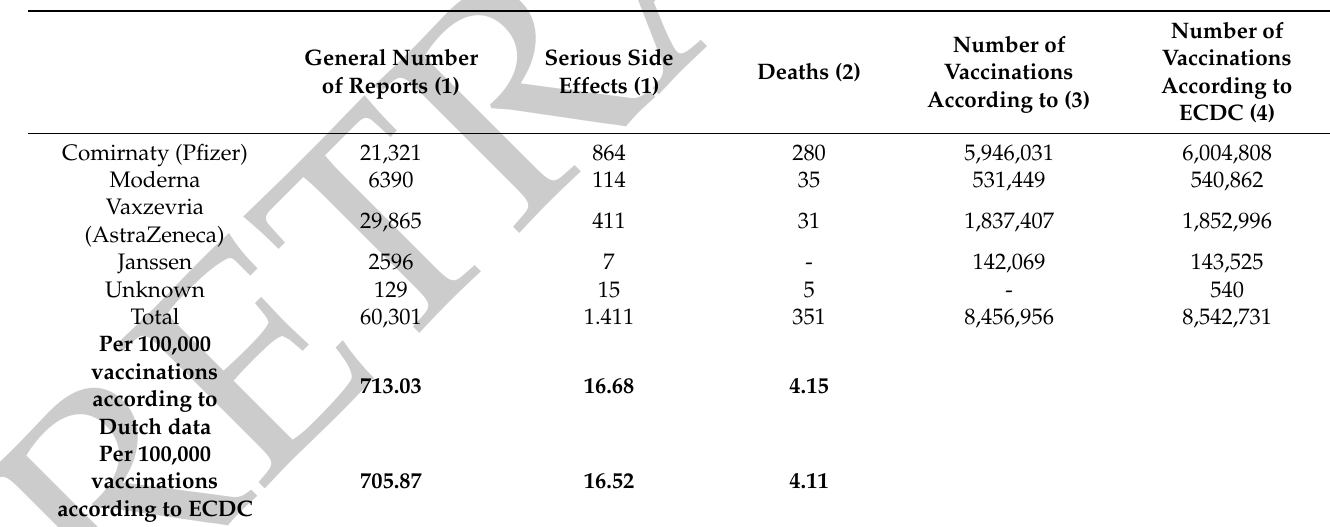
Table 3. Individual case safety reports for the most widely distributed COVID-19 vaccines according to the Dutch side effects register (www.lareb.nl/coronameldingen (accessed on 29 May 2021)), the absolute numbers per vaccine, and standardization per 100,000